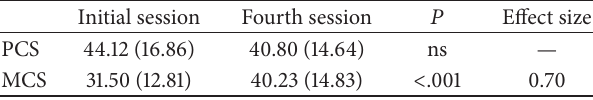
Table 2: HRQOL outcomes at fourth telepsychology